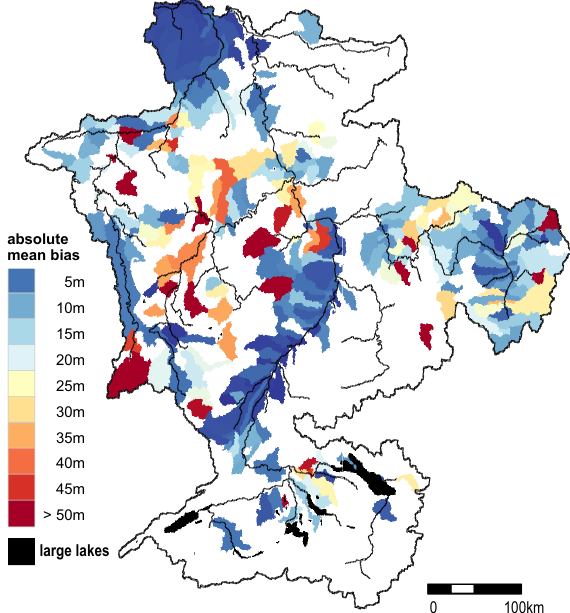
Fig. 7. The sub-basins used to analyze the model performance. The locations and the number of head measurement stations in each of sub-basin are also illustrated.